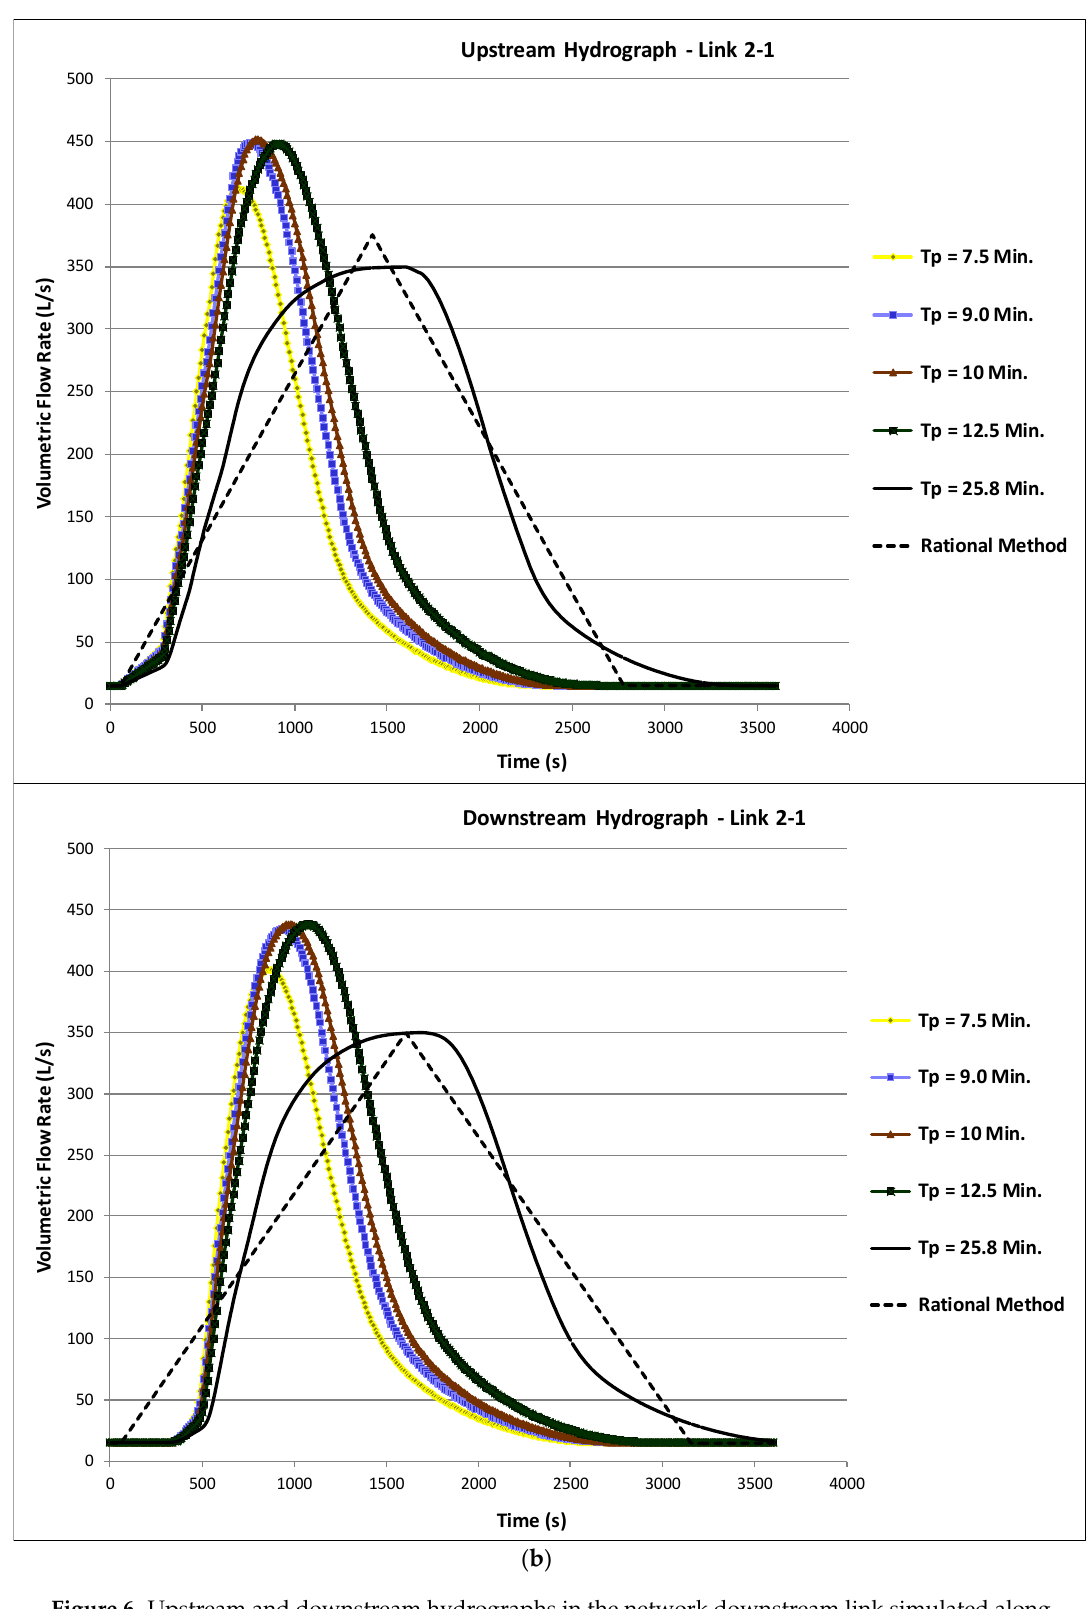
Figure 6. Upstream and downstream hydrographs in the network downstream link simulated along a dendritic network for several times of precipitation. ( a ) Base criteria. ( b ) With a Tc increase in one branch.